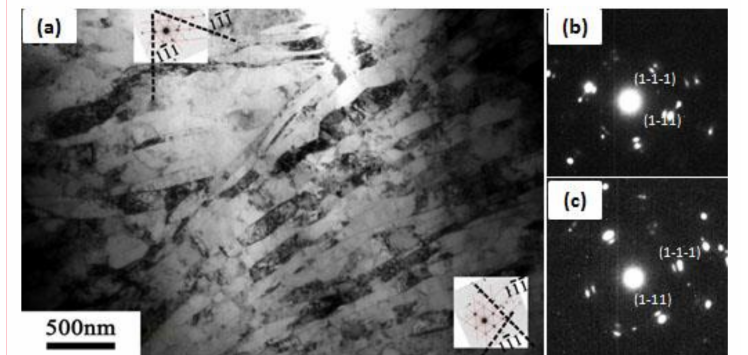
Figure 6. Bright-field TEM image ( a ) of pure Cu after 6 ARB passes: ( b ) and ( c ) are the corresponding SAED patterns of the upper-left corner and lower-right corner in ( a ), respectively. The SAED patterns were obtained from a circle region with 750 nm in diameter.